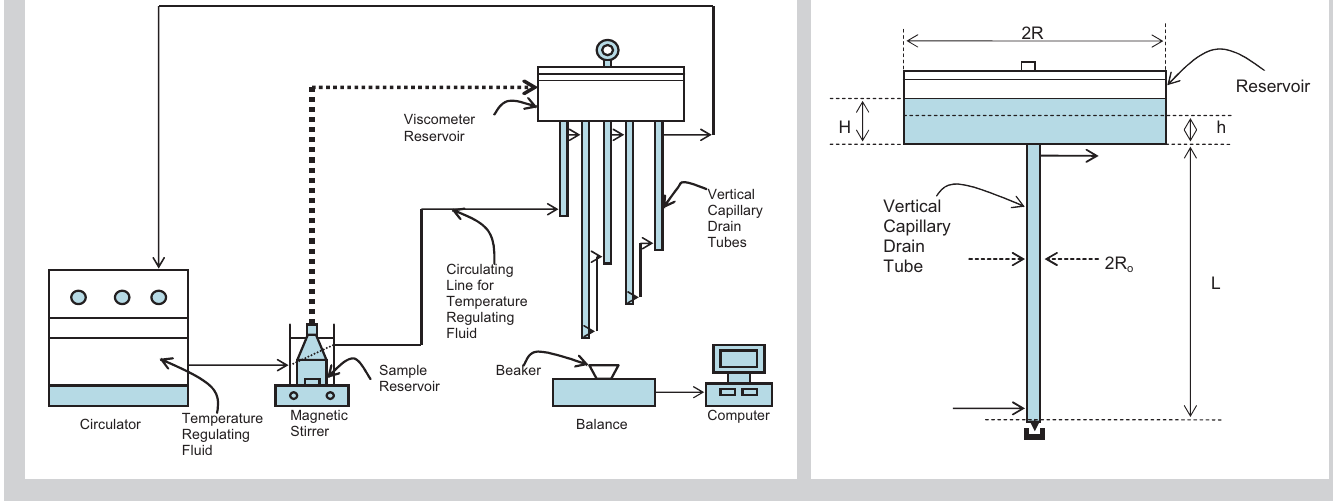
Figure 1 (left): A schematic diagram of a tank-tube viscometer. Figure 2: Single vertical capillary